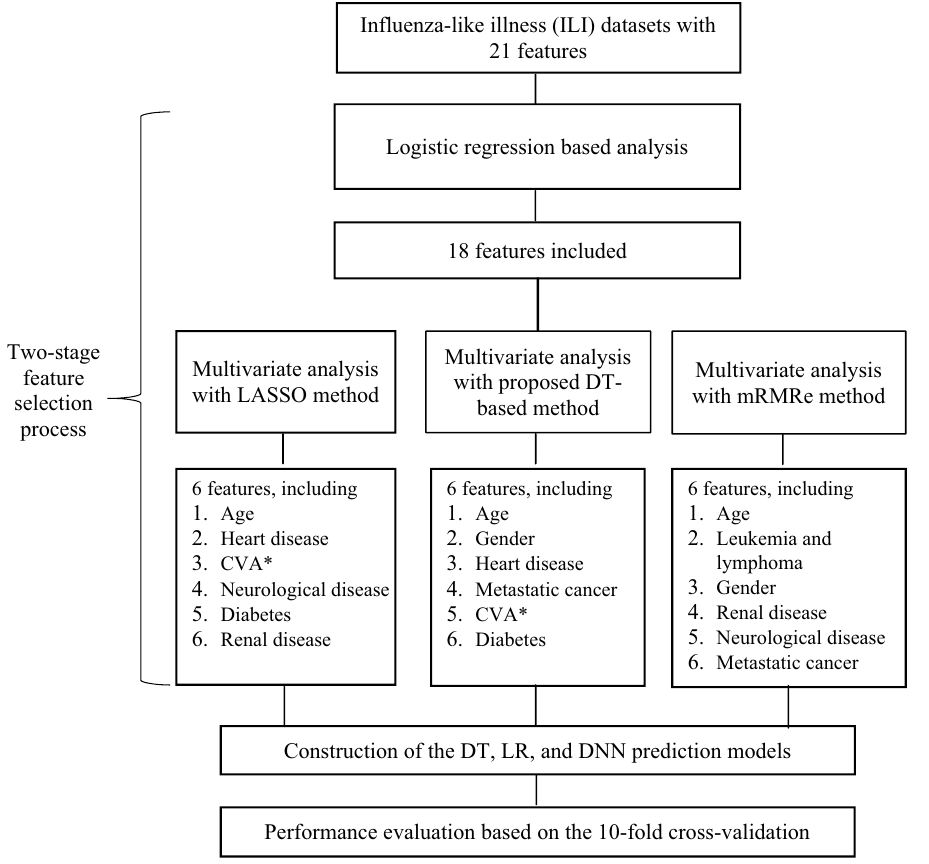
Figure 2. The experimental procedures. The analysis began with a 2-stage feature selection process. In the first stage, the conventional logistic regression analysis was employed to eliminate those features that were uncorrelated to the outcome variable. In the second stage, the proposed DT-based method along with two advanced multivariate analysis methods, namely being the least absolute shrinkage and selection operator (LASSO) method 40 and the ensemble variant of minimum redundancy maximum relevance (mRMRe) method 41,42 , were employed to generate three 6-variable feature sets. Then, these three 6-variable feature sets were employed to build the DT, LR, and DNN prediction models. Finally, the performance of the alternative prediction models was evaluated based on the 10-fold cross validation process. * CVA cerebrovascular